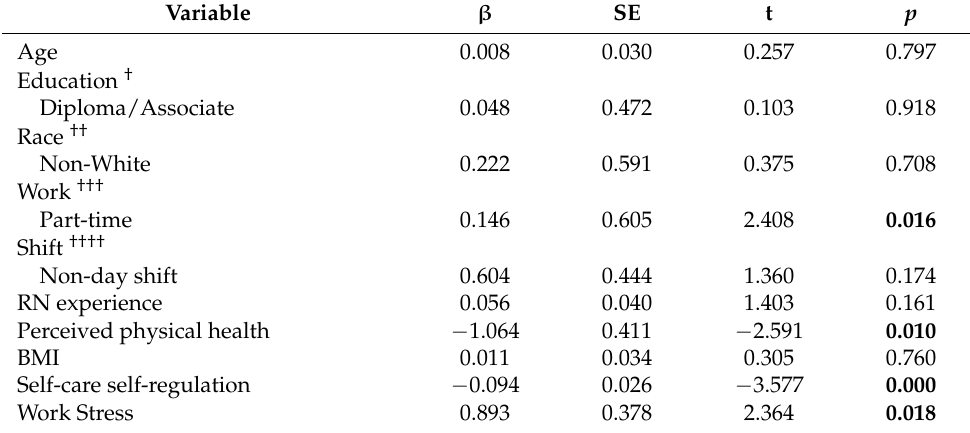
Table 3. Multivariate regression for variables associated with PSQI ( n = 215).